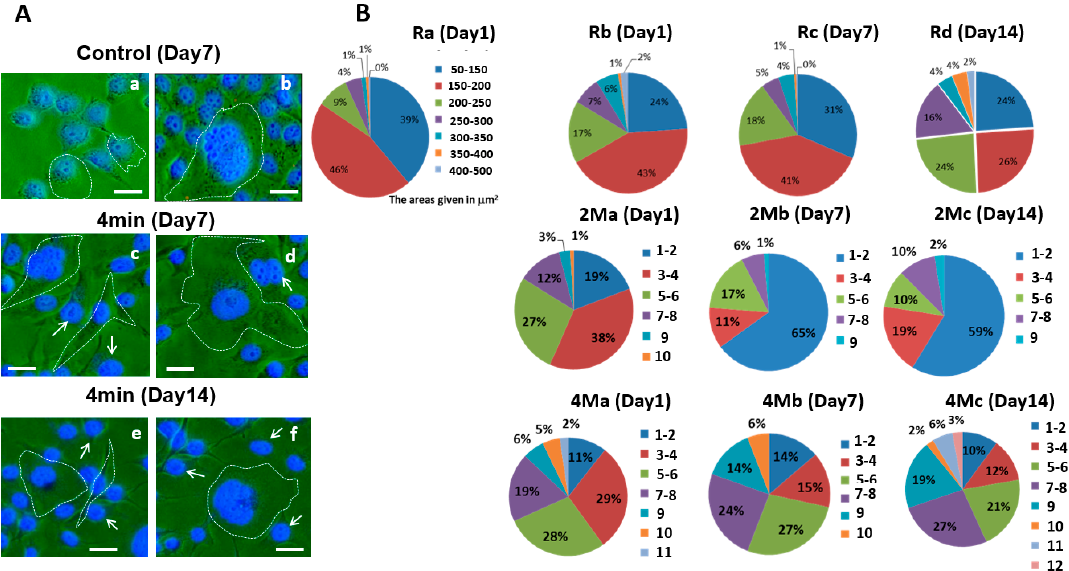
Figure 3. The distribution of the nuclei sizes and shapes in control and treated H1299 cells populations in response to MMW irradiation. ( A ) Representative images of nuclei morphology after irradiation. (a) Control cells nuclei show circle or oval morphology; (b) cells with enlarged nuclear morphology under the 2 min irradiation regime corresponding to subgroups 1–2 from Table 2 observed over long-term incubation of 7–14 days after MMW treatment; (c) and (e) cells with altered nuclear morphology under the 4 min irradiation regime observed on the day of experiment (Day 1); and (d) and (f) cells with enlarged nuclear morphology under the 4 min irradiation regime corresponding to subgroups 4–10 from Table 2 observed over long-term incubation of 7–14 days after MMW treatment. Arrows indicate altered nuclei as compared to control. Scale bars correspond to 10 μ m. ( B ) Distribution of H1299 lung cancer cells by nuclei area size. Nuclei distribution by size of reference groups. The areas indicated are given in µm 2 . Ra–d correspond to control groups of four separate dishes (Ra, Rb, Rc, and Rd). The group Ra was imaged and fixed before the experiment. The control groups Rb, Rc, and Rd accompanied all the MMW treated samples undergoing the same procedure as the experimental groups except the irradiation; for proper comparison of the experimental groups with the control ones at all stages of the experiment since the morphological and physiological properties of the cells change during physiological incubation due to normal proliferation. During the whole experiment the average size of nuclei measured increased. 2 Ma–c correspond to 2 min exposure and 4 Ma–c corresponds to 4 min exposure, respectively. The areas of nuclei increase over time from Day 1 to Day 14. The groups 2 Ma and 4 Ma represent the acute e ff ect of MMW irradiation on Day 1 of MMW treatment. The groups 2 Mb–c and 4 Mb–c represent the chronic e ff ects of MMW irradiation observed over 7–14 days after MMW treatment. The values in the legends denote ratios of measured areas of the experimental groups to the average area (160 um 2 ) of the control groups on corresponding days. The percentage given in pies represent the actual percent of the indicated subgroup within whole population. The basic e ff ect of the irradiation for both exposure durations show that nuclei grow in size, and 4 min exposure leads to remarkable increase in the number of multi-nuclear cells. The number of cells were measured in each group per experiment was 400–550. Each experiment involved four